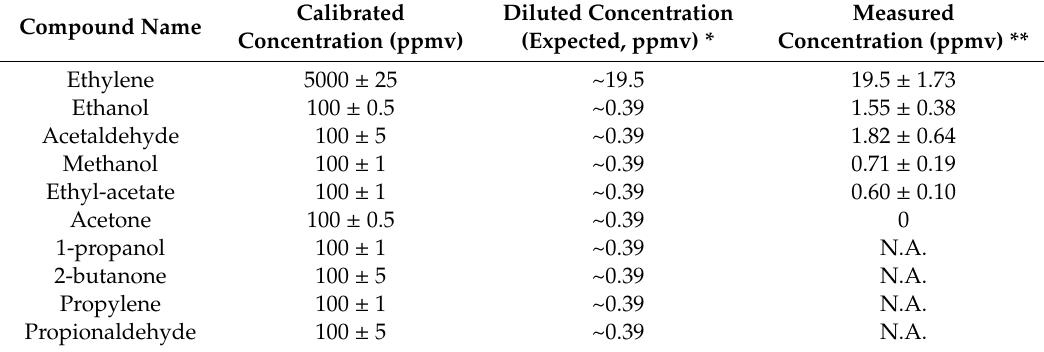
Table 1. Concentration overview of the gas mixture diluted from a calibration gas source containing nine species (second column) in comparison with the measurement results (fourth column).